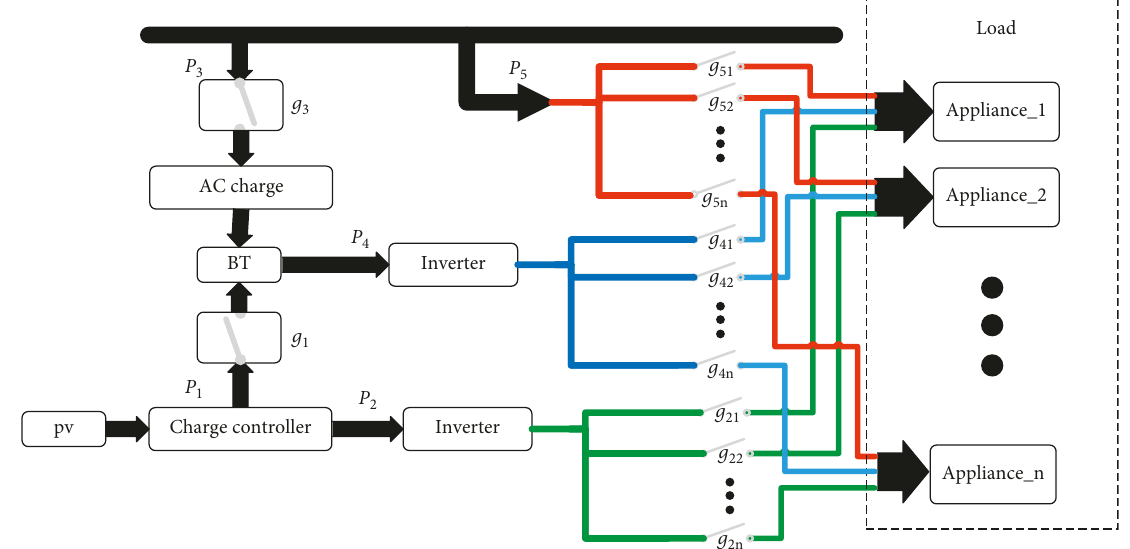
Figure 2: Schematic of the investigated power management